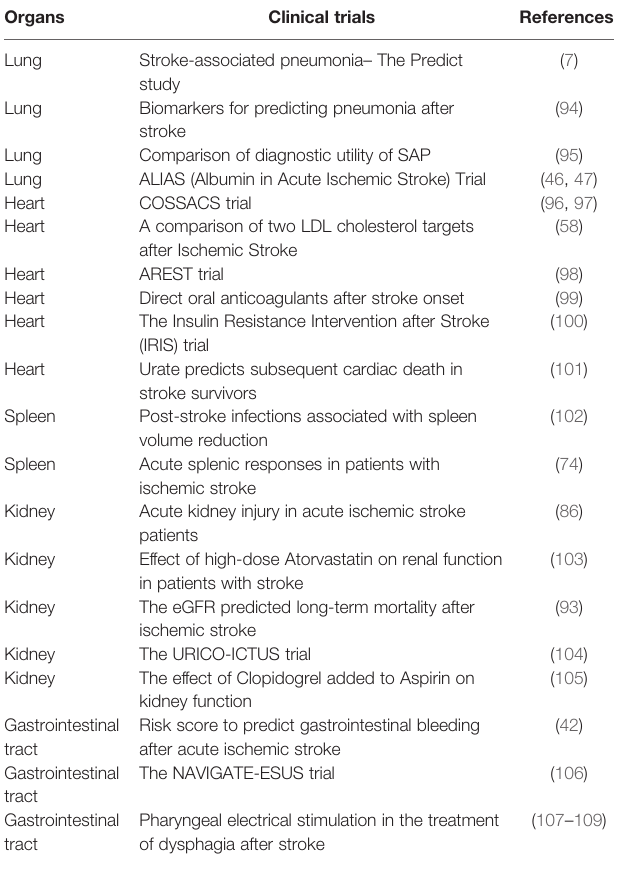
TABLE 2 | Clinical trials targeting the peripheral organs injury after